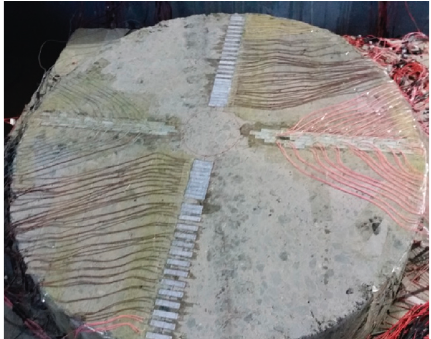
Figure 7: Distribution of strain gauges.